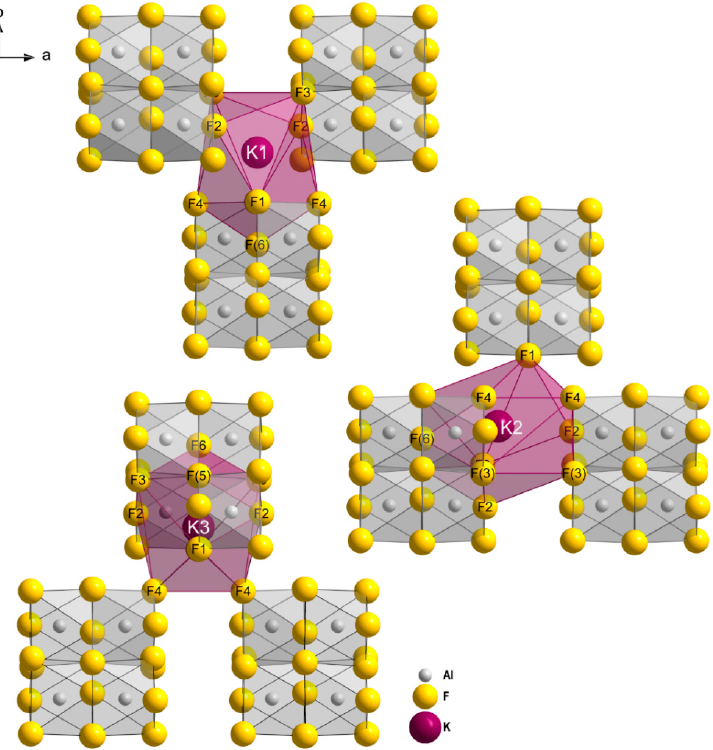
Figure 3. Interconnection of the infinite fluoridoaluminate zig-zag chains by potassium ions in K 2 AlF 5 -2.